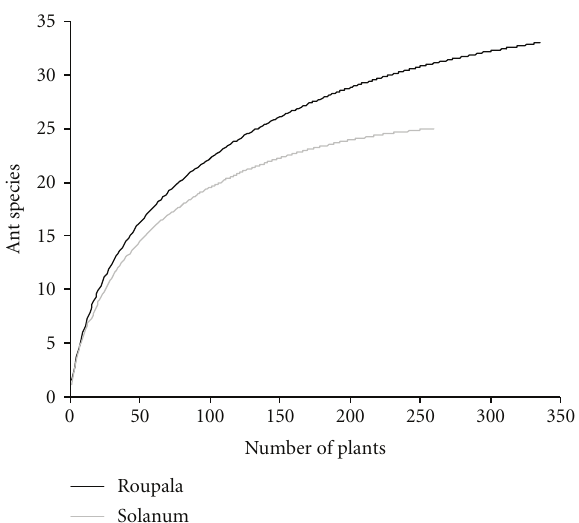
Figure 1: Rarefaction curves of ant species collected on Roupala montana (Proteaceae) and Solanum lycocarpum (Solanaceae), in Fazenda Agua Limpa, Federal District,